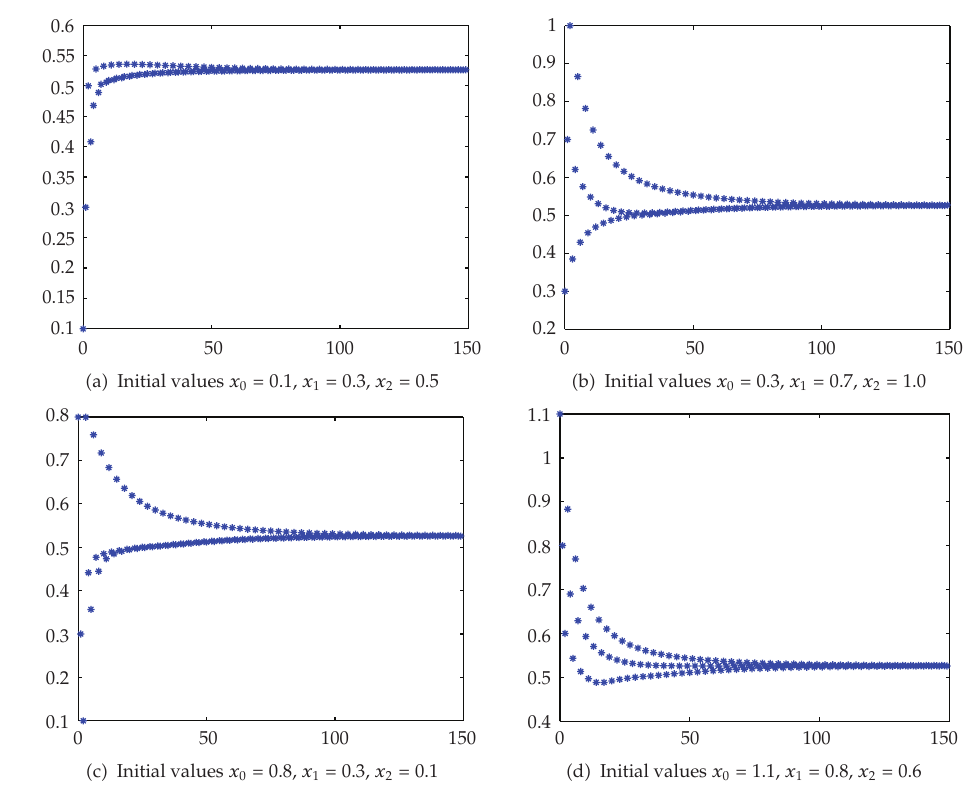
Figure 5: x ∗ (cid:5) 10 / 19 ≈ 0 .